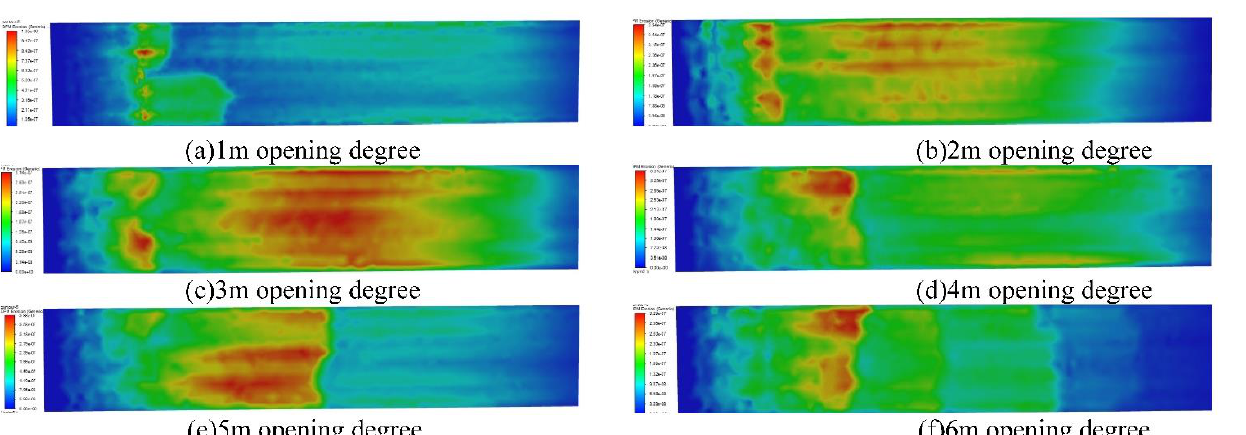
and 3 m and tends to be stable when the opening of the gate surface reaches 3 m.